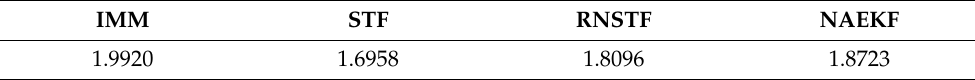
Table 13. Computing time